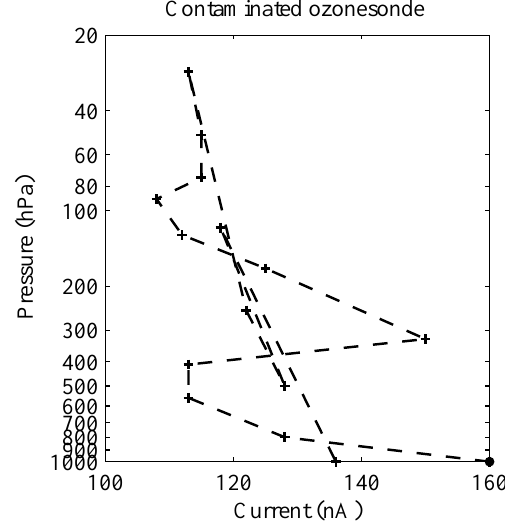
Figure A2. Current measured from the slightly contaminated ozonesonde as a function of